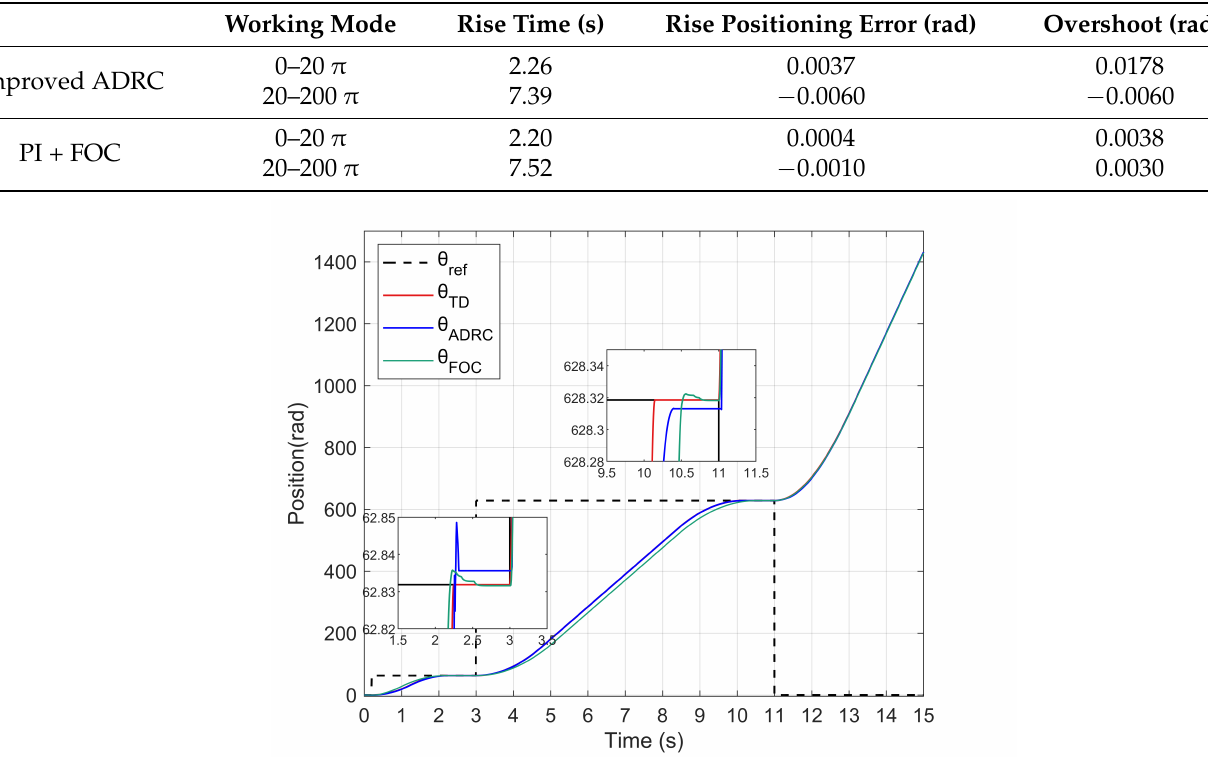
Figure 7. The actual position of the improved ADRC system and the PI + FOC